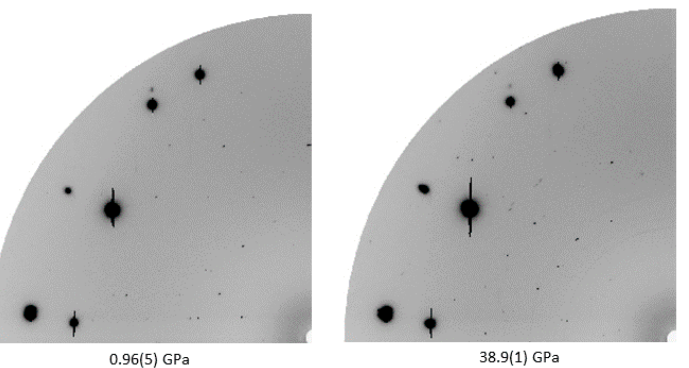
Figure 2. Diffraction patterns at the central detector position of low- and high-pressure phases of melamine, displaying the change in pattern before and after the reversible structural phase transition above 36 GPa in helium.